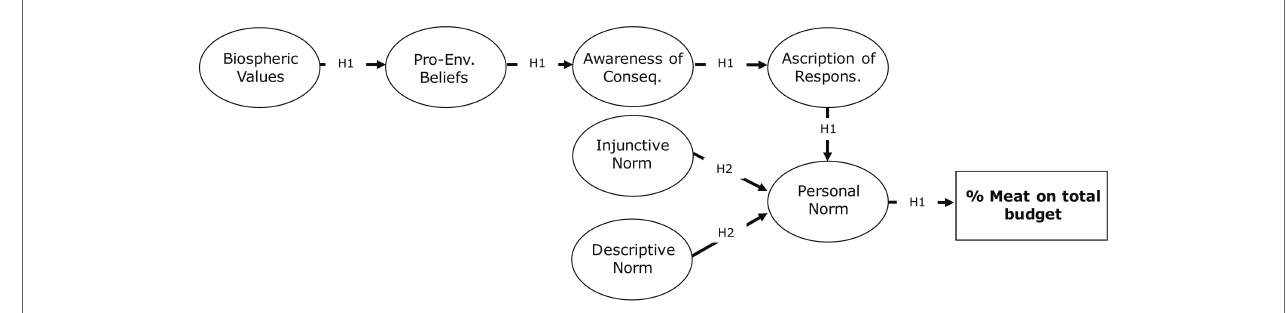
FIGURE 1 | Conceptual model and hypothesized paths of Study